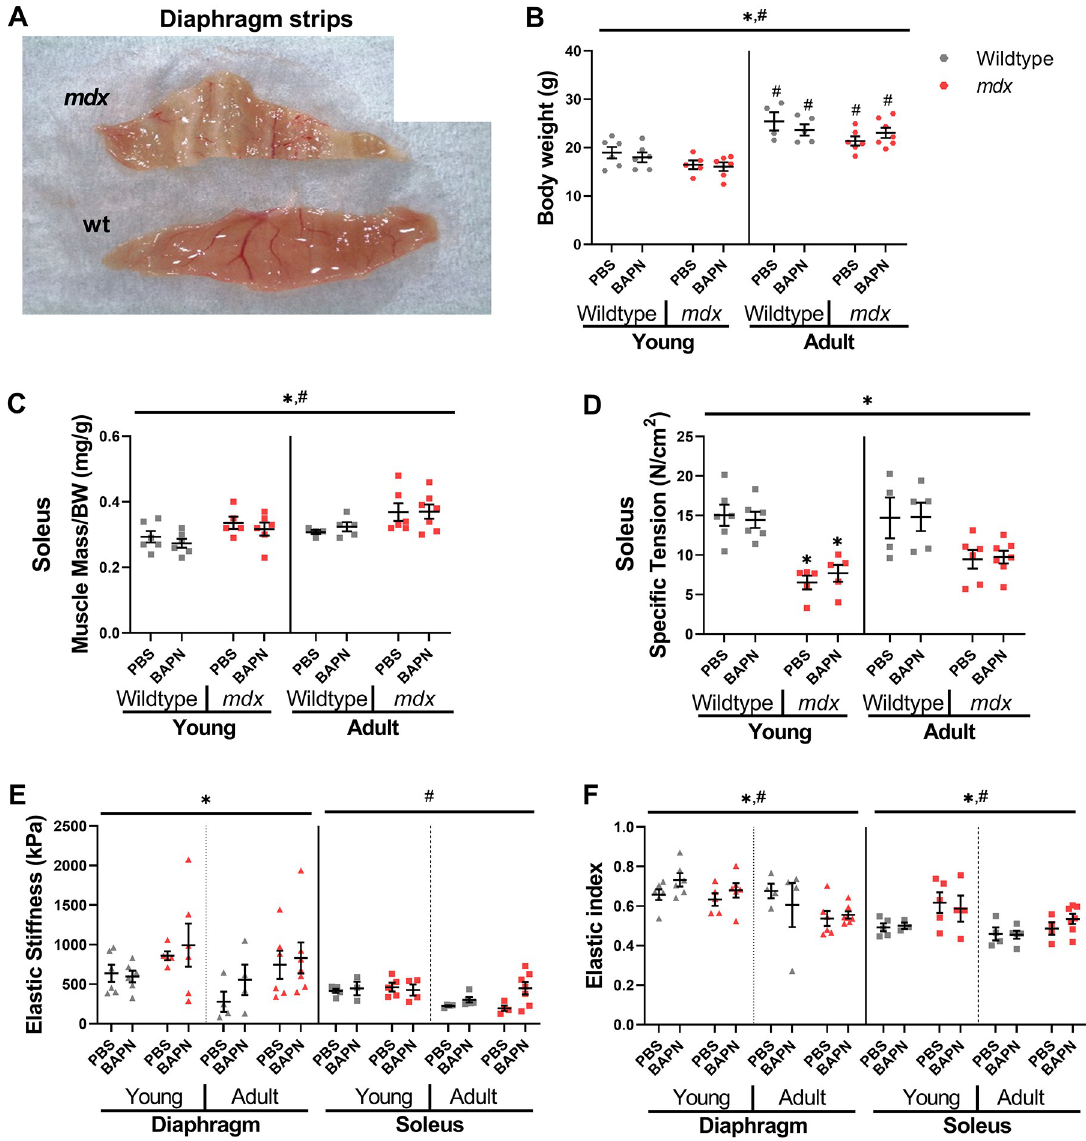
Fig 1. BAPN and muscle mechanics in wildtype and mdx . (A) Representative image of isolated wildtype and mdx diaphragm (DP) muscles for ex vivo mechanical testing. (B) Total body weight was greater for adult mice than young mice in both mdx and wildtype. (C) In soleus, there were significant effects of age and genotype on muscle mass. (D) The specific tension of mdx soleus muscles were significantly lower than wildtype. (E) Elastic stiffness taken as the elastic modulus at 10% strain showed mdx diaphragm was significantly stiffer than the wildtypes, and young soleus was significantly stiffer than adult soleus. (F) Elastic index, related to the amount of force remaining after stress relaxation compared with the peak force, showed significant effect of age and genotype in diaphragm and soleus muscles. � = genotype effect, # = age effects, � = p < 0.05 determined by three-way ANOVAs with post-hoc Sidak multiple comparisons